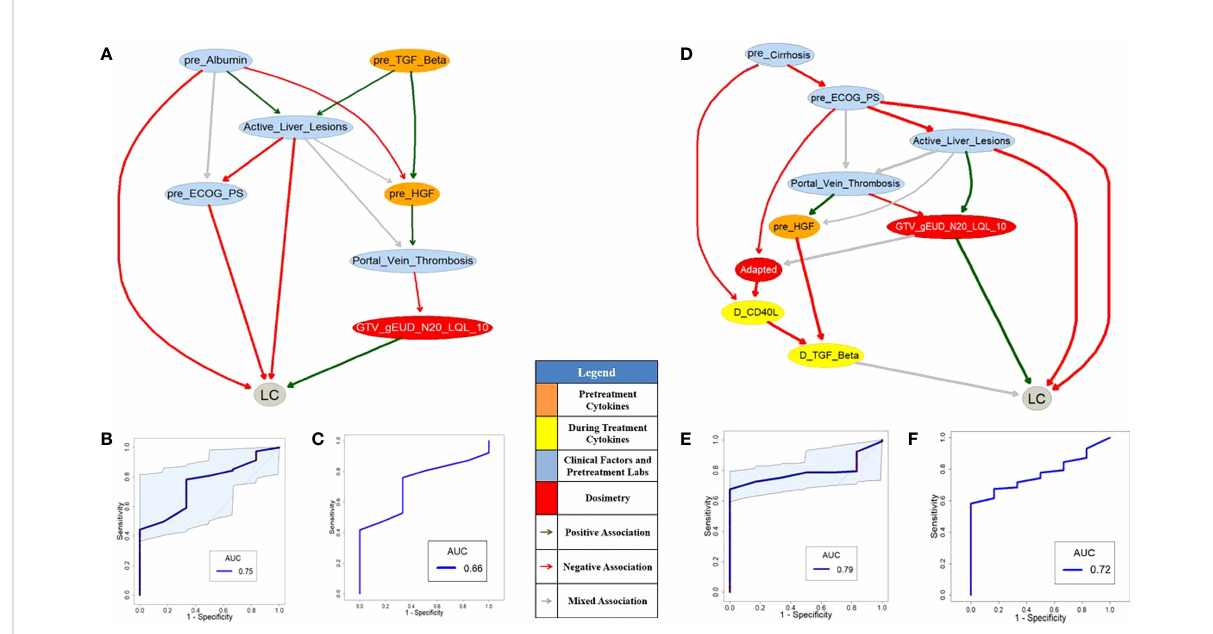
FIGURE 4 Pre- (A) and during-treatment (D) PD-BNs for LC prediction. The prediction performance of pre- (B) and during-treatment (E) PD-BNs based on the discovery dataset. The prediction performance of pre- (C) and during-treatment (F) PD-BNs based on the testing